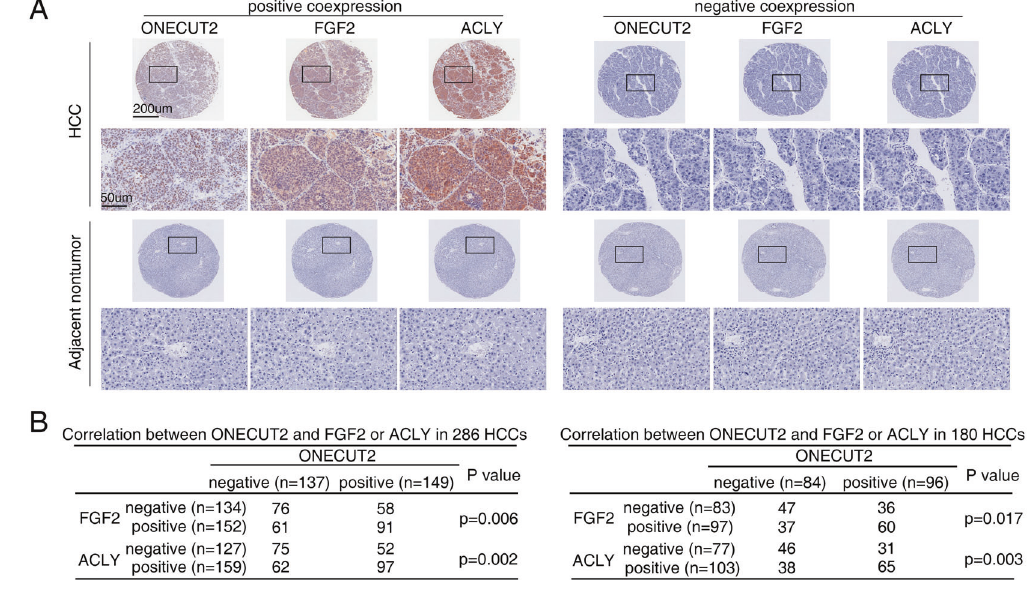
Cell Death and Disease (2021)